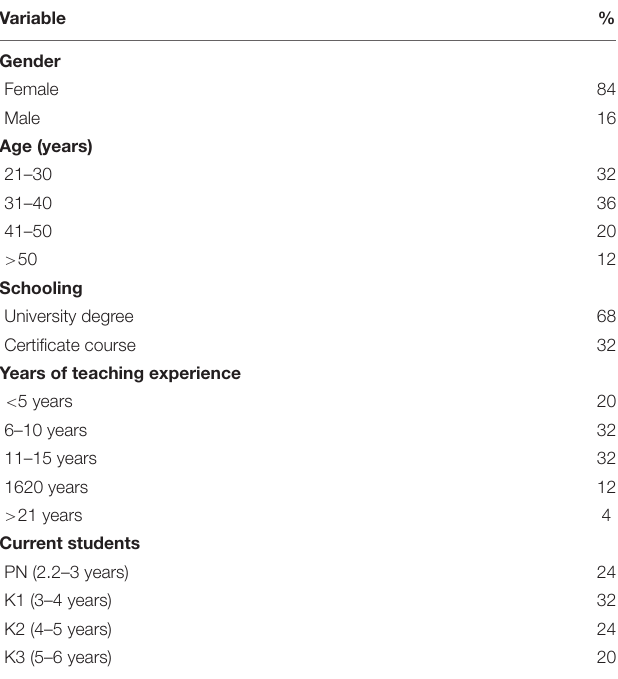
TABLE 1 | Participant’s demographics ( N = 25).